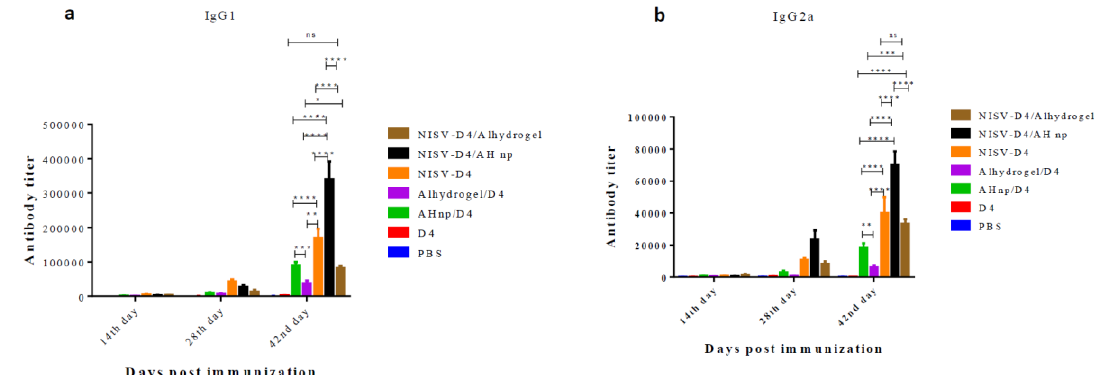
Figure 3. Anti-D4 (a) IgG1 and (b) IgG2a titres elicited by Swiss albino mice immunised via IP route with PBS, D4 only, AH np/D4, alhydrogel/D4, NISV-D4, NISV-D4/alhydrogel, and NISV-D4/AH np. Subsequent booster doses were administered on days 14 and 28. Sera were collected from individual mice and analysed in triplicate for D4-specific IgG antibodies. The results were expressed as mean value with standard deviation (SD) from each individual mice group. p -value was calculated between AH np adjuvanted groups and alhydrogel using two-way Anova followed by Tukey’s multiple comparison tests. * p < 0.05, ** p < 0.01, *** p < 0.001, **** p < 0.0001, ns represents non- significant.